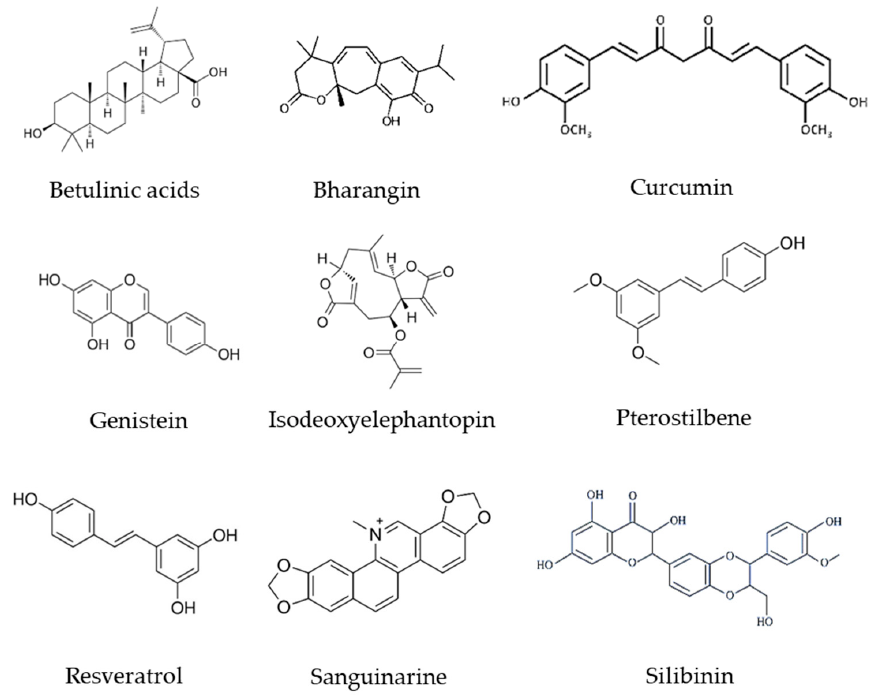
Figure 3. Chemical structure of phytochemicals involved in the invasion, migration, and metastasis of various cancers. of various